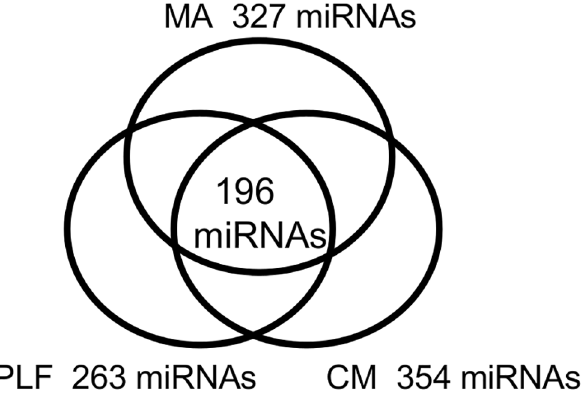
Fig 4. The number of miRNA species detected in malignant ascites, peritoneal lavage fluids, and cell culture media groups; 196 miRNAs were common to all groups.